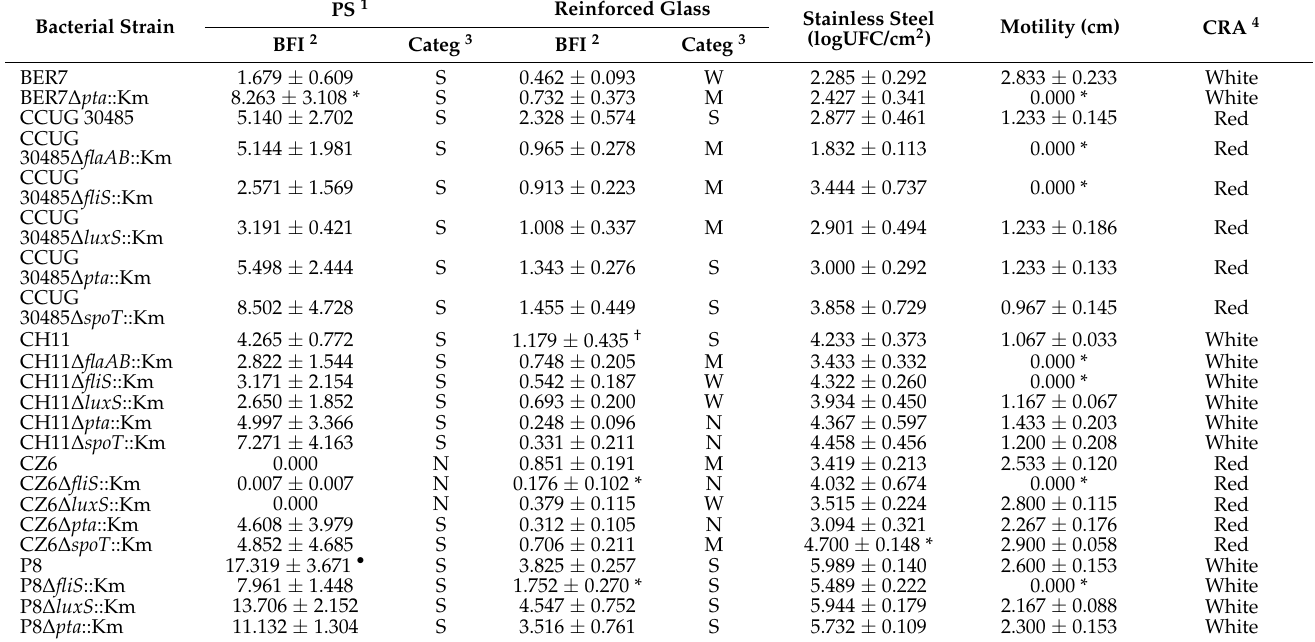
Table 2. Biofilm formation ability, motility and phenotype on CRA shown by the strains in this